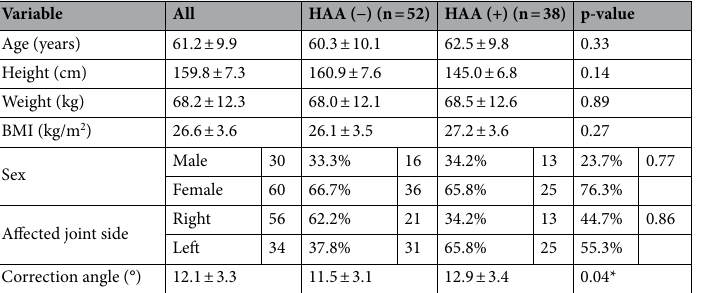
Table 1. Patient demographic. Data are shown as the means with standard deviation or number. BMI body mass